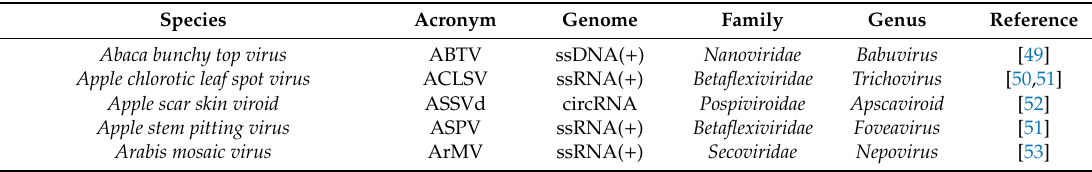
Table 1. Loop-mediated isothermal amplification (LAMP) protocols developed for di ff erent plant viruses and